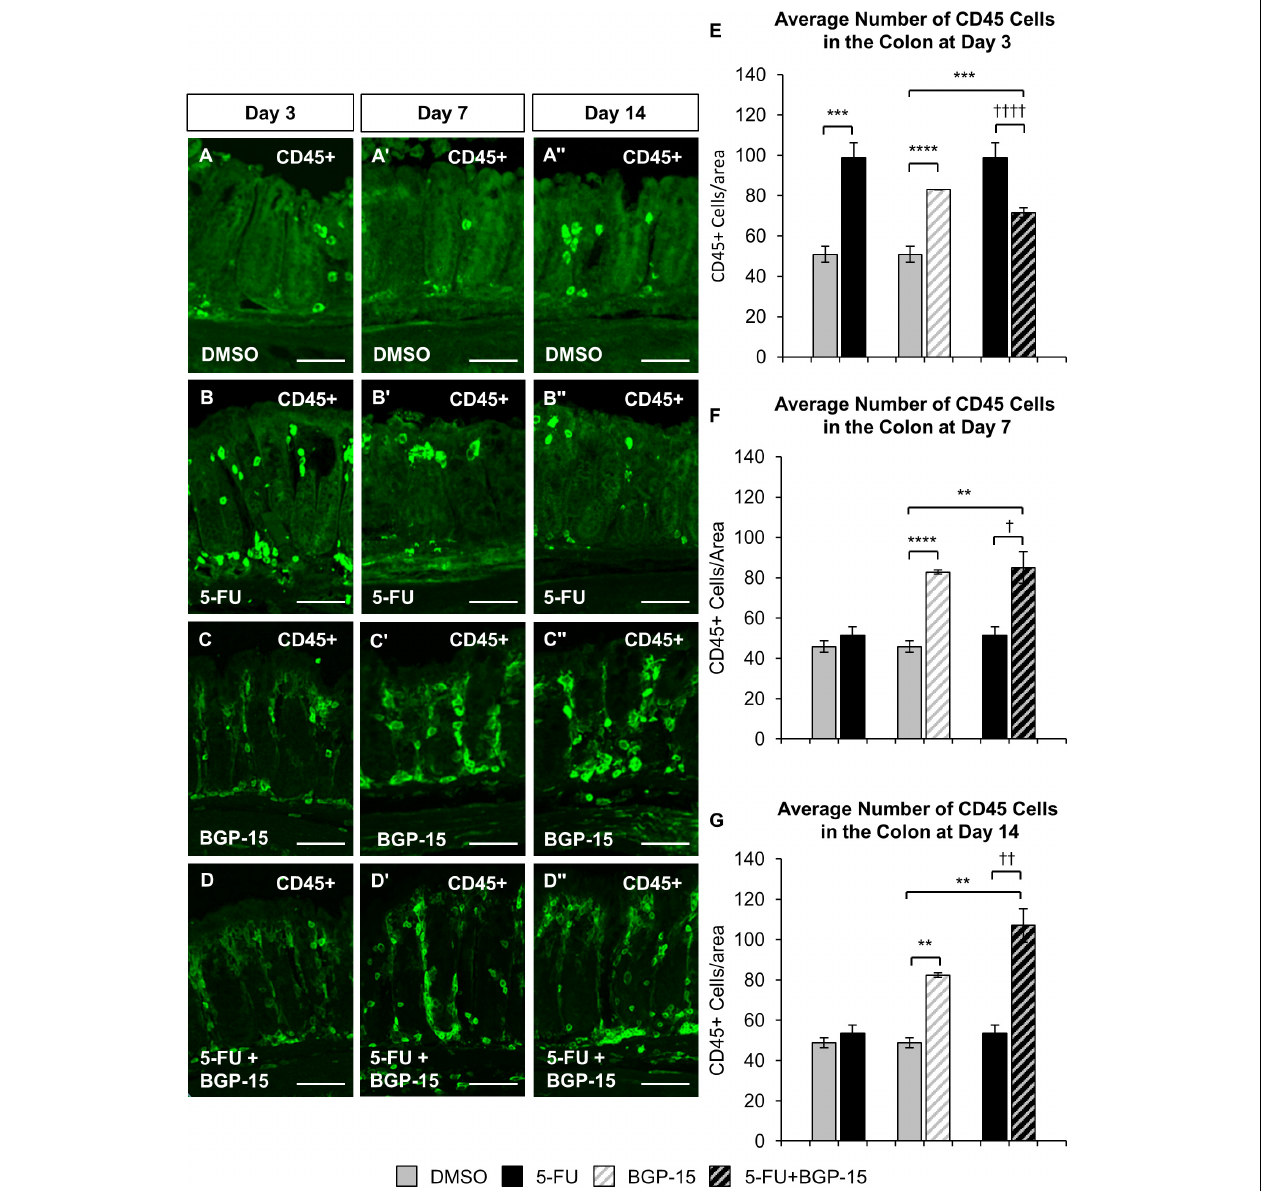
FIGURE 3 | Inflammation in the colon repeated in vivo 5-FU ± BGP-15 administration. Cross sections of the colon labeled with antibody against CD45+ leukocytes (green) following 3, 7, and 14 days of DMSO (A–A”) , 5-FU (B–B”) , BGP-15 (C–C”) , and 5-FU+BGP-15 (D–D”) treatment, scale bar = 50 µ m. Average number of CD45+ cells in the colon was counted per 2 mm 2 at 3 days (E) , 7 days (F) , and 14 days (G) in DMSO, 5-FU, BGP-15, and 5-FU+BGP-15-treated mice. Data represented as mean ± SEM. ∗∗ P < 0.01, ∗∗∗ P < 0.001, ∗∗∗∗ P < 0.0001 significantly different to DMSO, † P < 0.05, †† P < 0.01, †††† P < 0.0001 significantly different to 5-FU ( n = 5